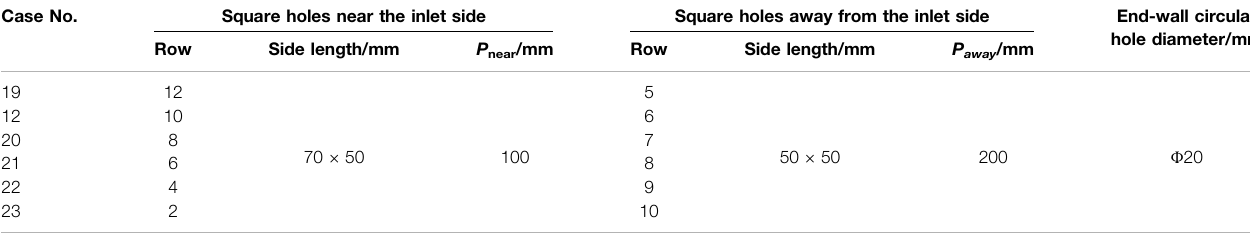
TABLE 7 | Characteristic geometrical parameters of fl ow homogenizers with different square hole row numbers. Case No.